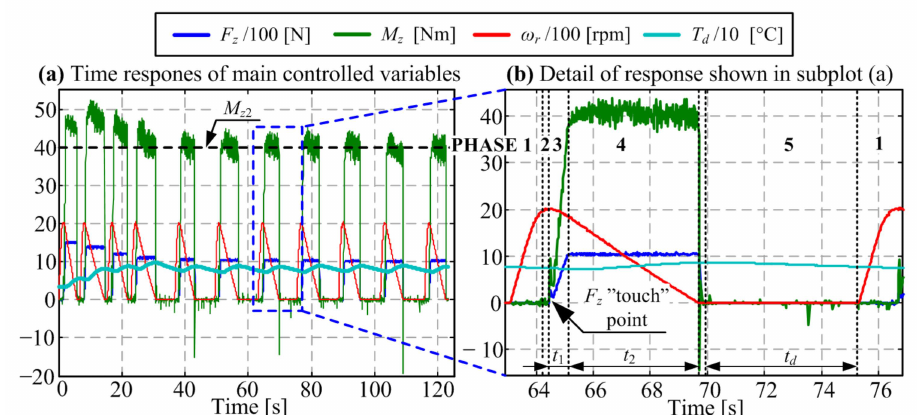
Figure 3. Experimental responses illustrating the organization of experiments (particular operating point corresponds to initial slip speed ω r 0 = 2000 rpm, torque M z 2 = 40 Nm, and closing time t 2 = 5 s). According to Equations (1) and (3), the friction material wear rate is determined based on the difference in friction plate mass ( ∆ m ) measured before and after each wear characterization experiment, and the energy dissipated ( E diss ) during the